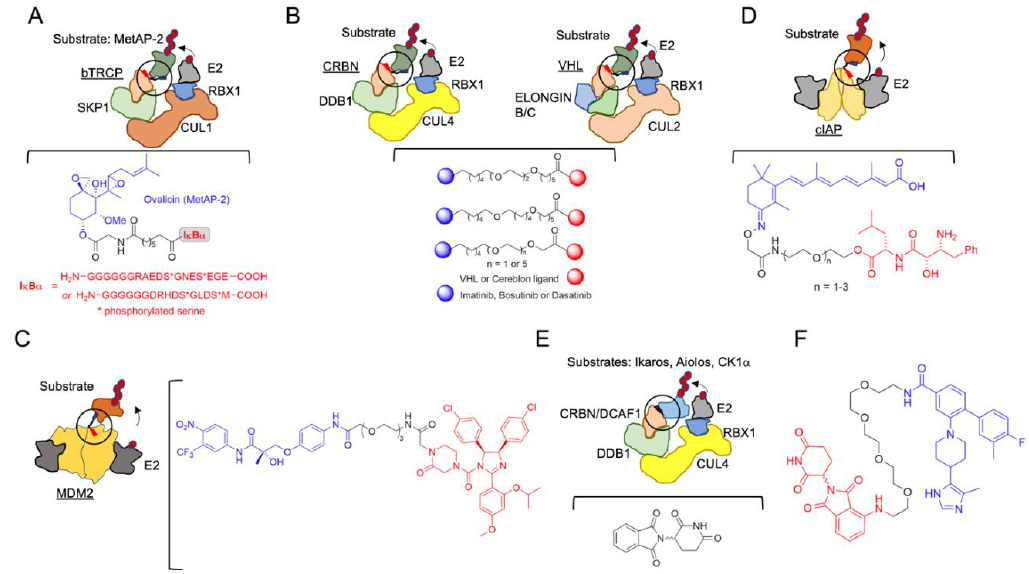
Figure 2. Protacs and E3 ligases. Schematic representation of the E3 ligases involved in TPD and the protac designed, as they appear in the text. RING ligases contain monomeric (e.g., PARKIN, UBR1), dimeric (e.g., cIAP, MDM2) [15,19] and multimeric forms. The Cullin RING multimeric ligase (CRL) superfamily [20] contains up to seven families, including Skp1-Cullin(Cul1)-Fbox (SCF), the DDB1-Cul4 and the elongin B, C-Cul2 / 5-SOCSbox protein (ECS). Thus, CRL1 TIR1 , CRL2 VHL , CRL4 DDB1 and CRL4 CRBN , mentioned in the text, belong to these families [21–24]. ( A ) Structure of Protac-1, the first TPD developed. ( B ) Small-molecule protacs to target the breakpoint cluster region—Abelson tyrosine kinase (BCR-ABL). ( C ) Protac for a non-steroidal androgen receptor ligand (SARM) and the MDM2 ligand nutlin. ( D ) An example of SNIPERs to recruit the homodimeric E3 cellular cIAP1 for the degradation of retinoic acid-binding proteins (CRABP-I and II). ( E ) The structure of thalidomide and its role as degrader. ( F ) Protac d9A-2 for the degradation of SLC9A1 from leukemic cells. E3 ligase ligands are shown in red and ligands for the POIs are shown in blue. Black circles show the regions of interaction induced by the degrader molecule. Curved arrows represent the ubiquitination process by the transfer of ubiquitin moieties (red